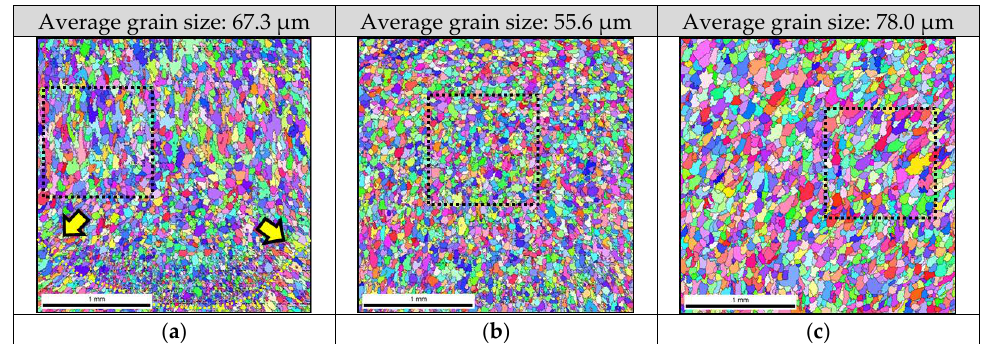
Figure 13. EBSD results for ( a ) R EN = 0, ( b ) R EN = 0.25, and ( c ) R EN = 1. The specimens were prepared under the conditions of a welding speed of 0.5 m/min and one repetition.